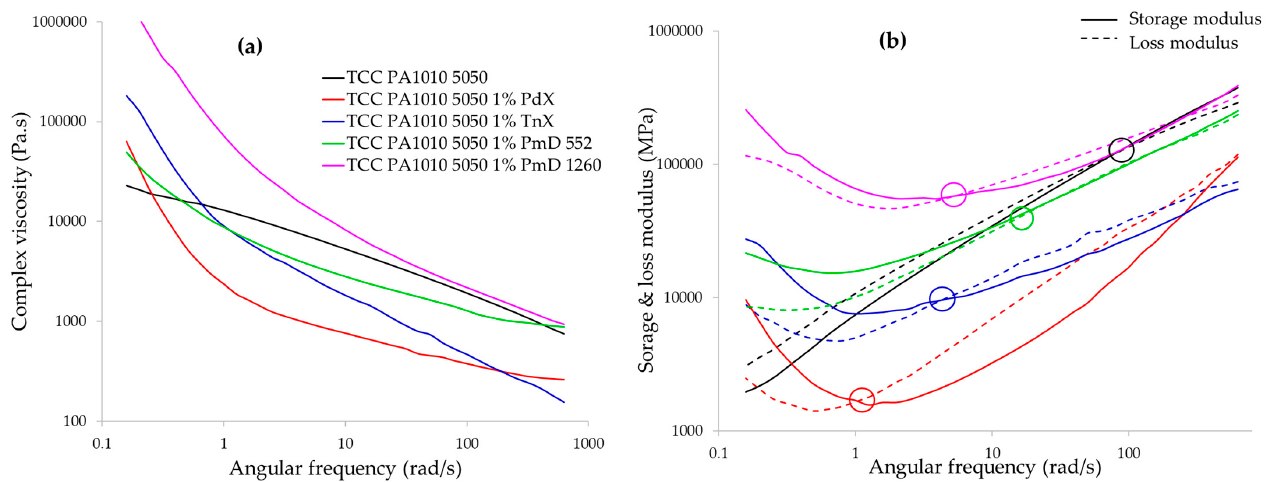
Figure 5. ( a ) Complex viscosity and ( b ) storage (G’) and loss (G’’) moduli of TcC/PA1010 and TcC/PA1010 containing PdX, TnX, PmD 552 and Pm 1260 cross-linkers.